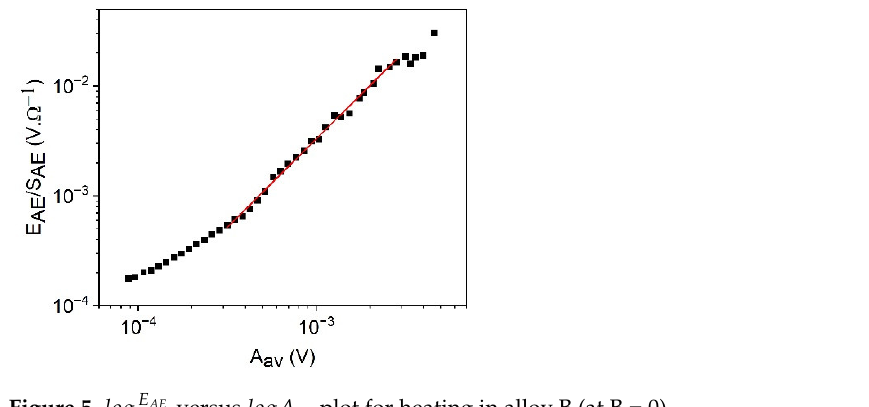
Figure 5.    versus   plot for heating in alloy B (at B = 0). Figure 5. log E AE versus logA av plot for heating in alloy B (at B = 0). S AE